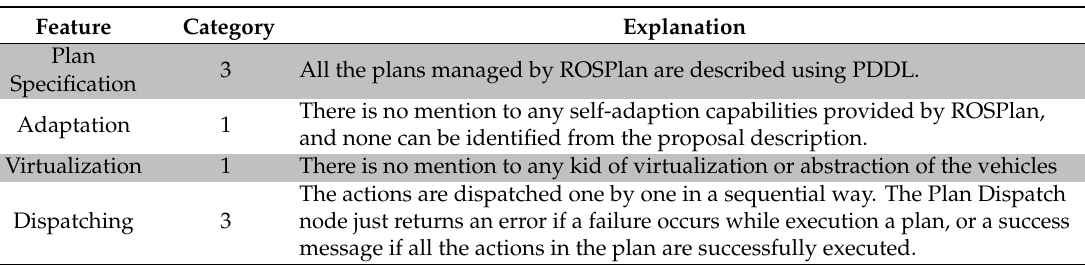
Table 12. ROSPlan assessment.